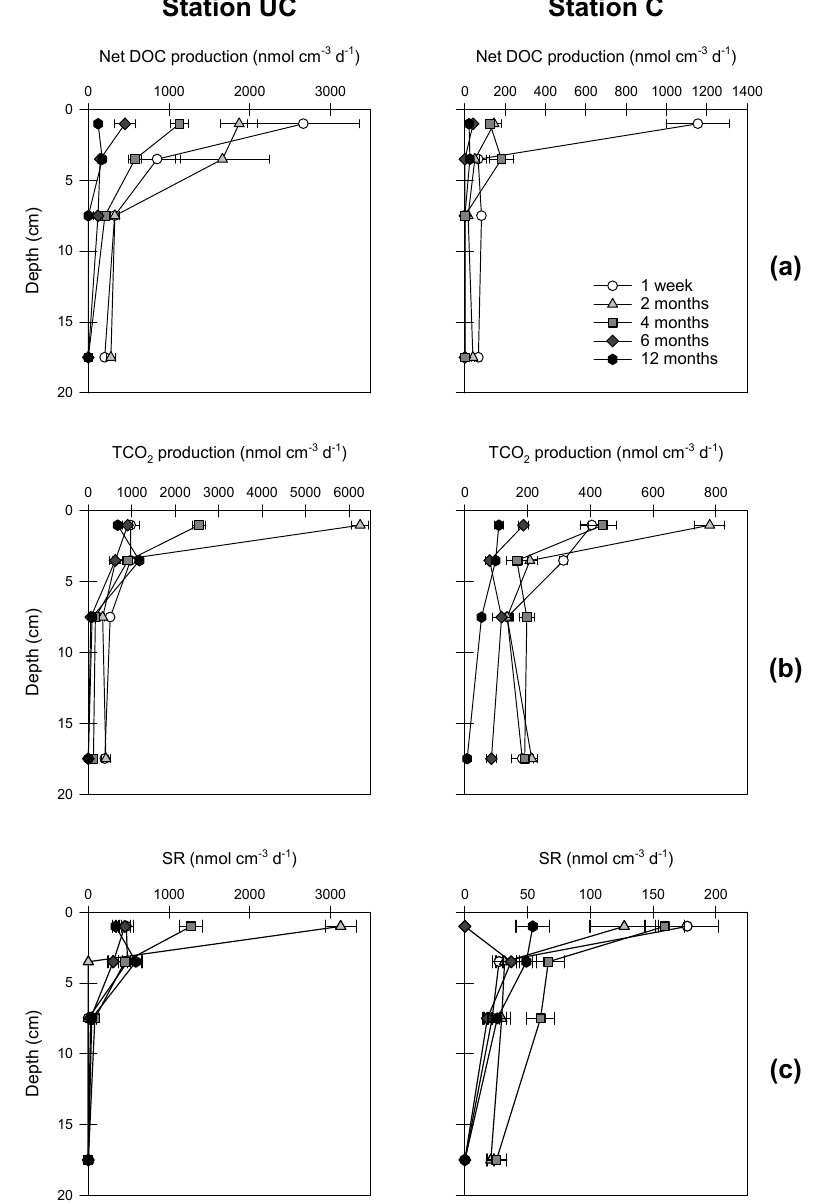
Figure 4. Temporal and spatial variability in production of dissolved organic carbon (DOC, a ) and carbon dioxide (TCO 2 , b ) and sulfate reduction (SR, c ) measured in jar experiments with uncultivated (UC) and cultivated (C) soils flooded with seawater. Note the different x axis scaling for UC and C measurements. Error bars indicate